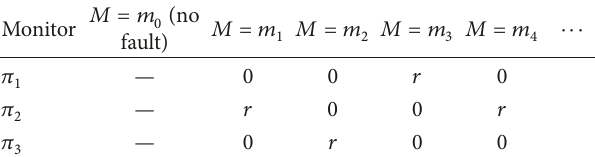
Table 1: A priori response